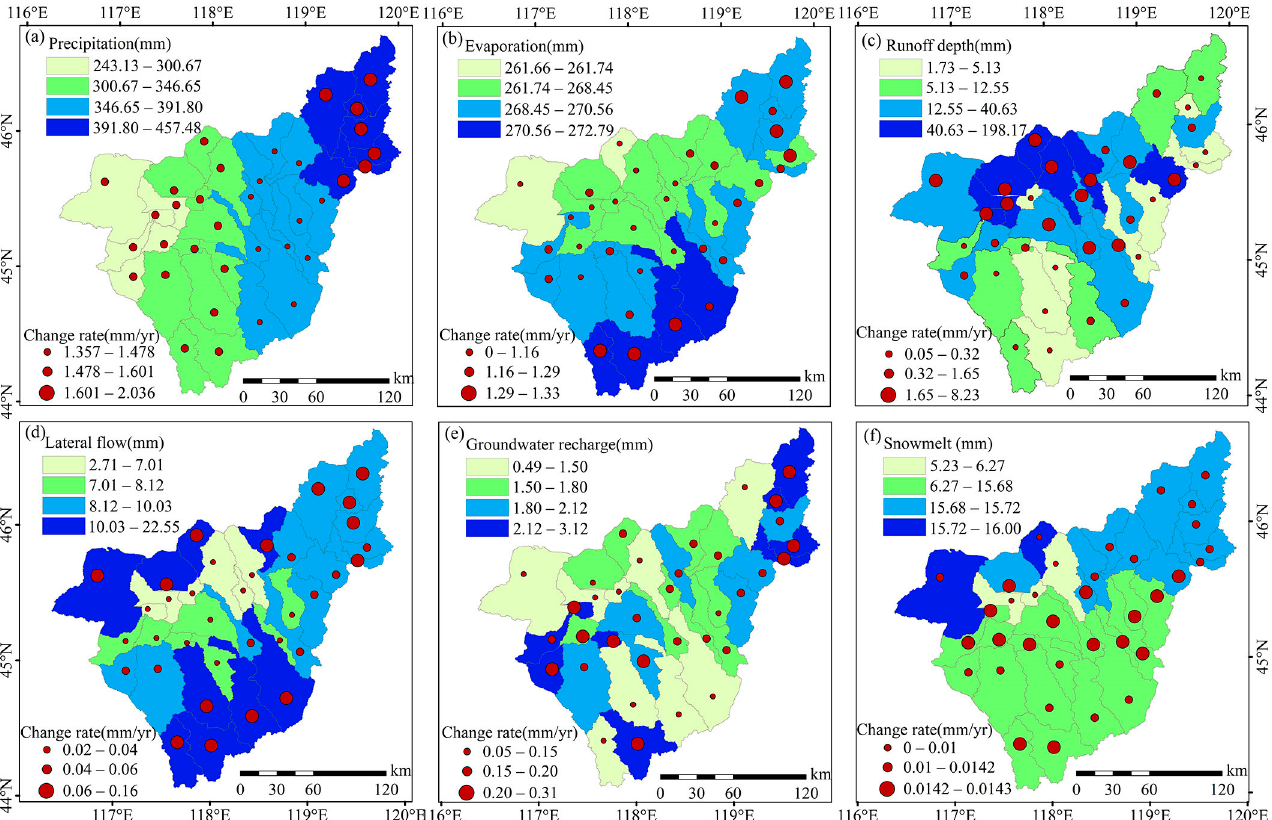
Figure 4. Spatial distribution and change rate of the URB’s hydrological process factors, 2001–2019: ( a ) precipitation, ( b ) ET, ( c ) runoff depth, ( d ) lateral flow, ( e ) groundwater recharge, and ( f ) snow- melt.